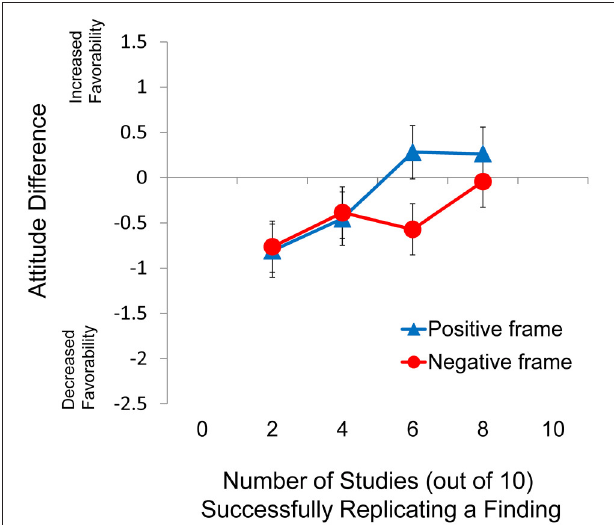
FIGURE 3 | Difference score as a function of frame for Experiment 3. Error bars indicate 95% confidence intervals.